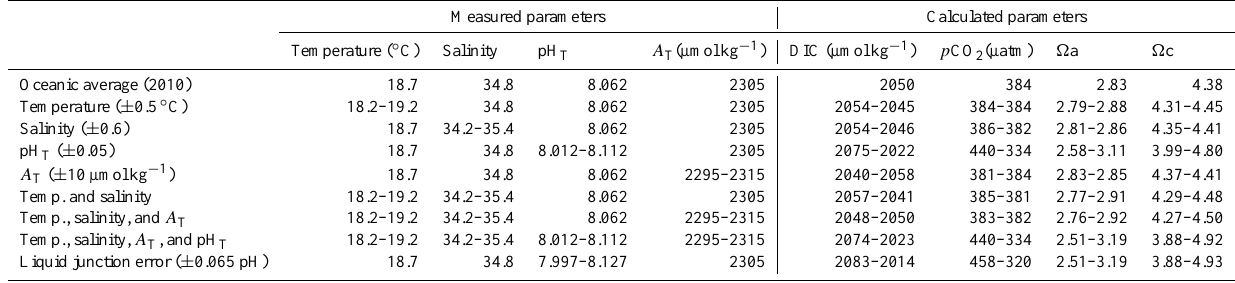
Table 3. A comparison of the offsets resulting in calculated carbonate parameters by offsets or calibration errors in measured variables. The top line shows calculated values for DIC, p CO 2 , (cid:127) a, and (cid:127) c, calculated based on the average oceanic values for temperature, salinity, pH, and A T reported in Riebesell et al. (2010). Text in bold indicates the parameter that was varied. Measured parameters Calculated parameters